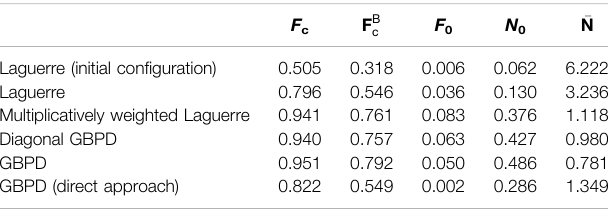
TABLE 2 | Values of performance measures for various tessellation models fi tted tothe perturbed simulated image I pert with σ (cid:1) 1and evaluatedwith respect to the smooth simulated image I sim .